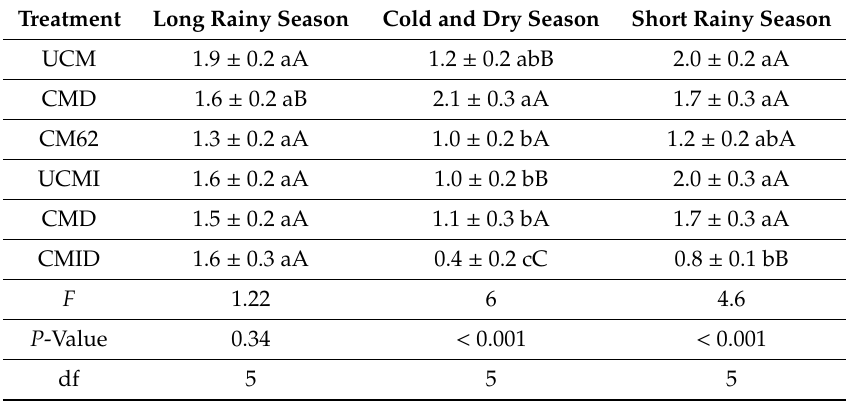
Table 2. Cowpea plant damages as influenced by the di ff erent treatments during the three seasons using the ranking